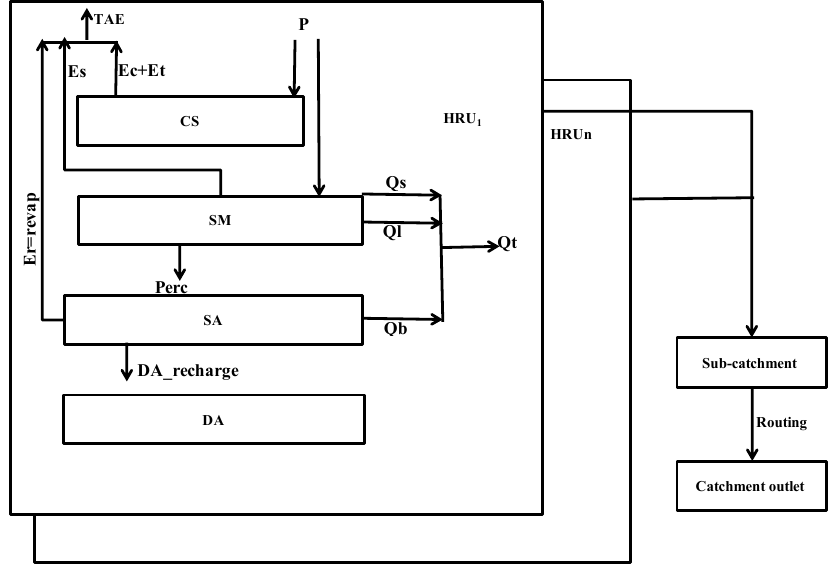
Figure 2. Schematic representation of the SWAT model structure modified from Marhaento et al. (2017). P is precipitation; CS is canopy storage; TAE is total actual evapotranspiration; E c is evaporation from the canopy surface; E s is evaporation from the soil surface; E t is transpiration from plants; Perc is percolation from the soil storage to shallow aquifer; SM is soil-moisture storage; SA is shallow aquifer; E r = Revap is evaporation from the shallow aquifer; Q t is total streamflow; DA is deep aquifer; HRU is hydrological response unit; Q b is base flow; Q l is lateral flow; and Q s is surface